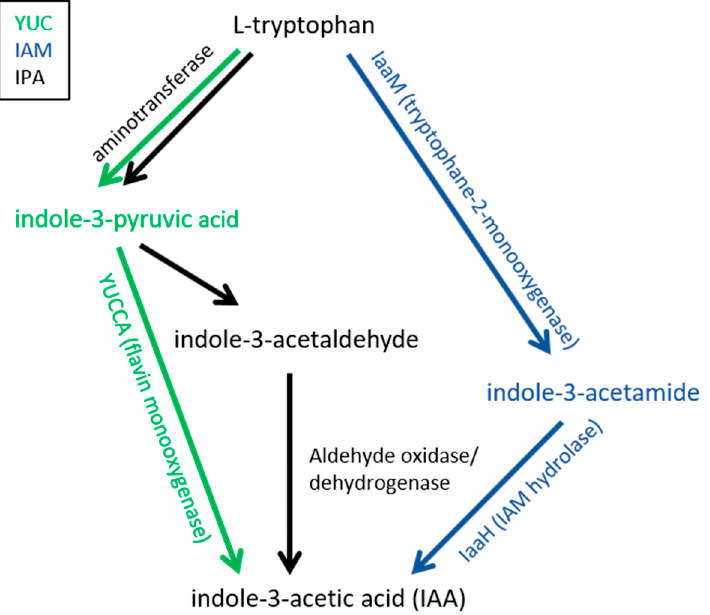
Figure 3. Tryptophan derived auxin biosynthetic pathway in plants (YUC (green)) and proposed pathways in Colletotrichum spp . (IAM (violet), IPA (black)).